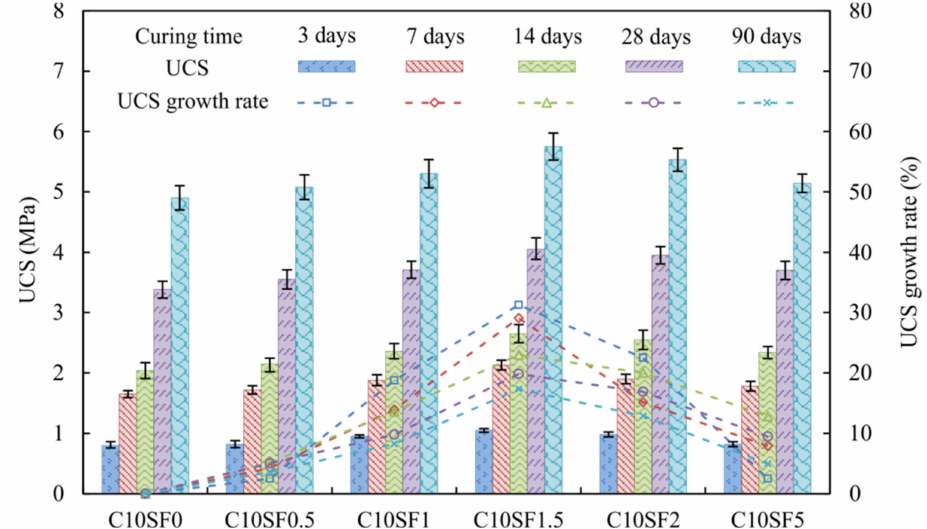
Figure 4. The UCS and UCS growth rate of cement stabilized soft soils with various SF